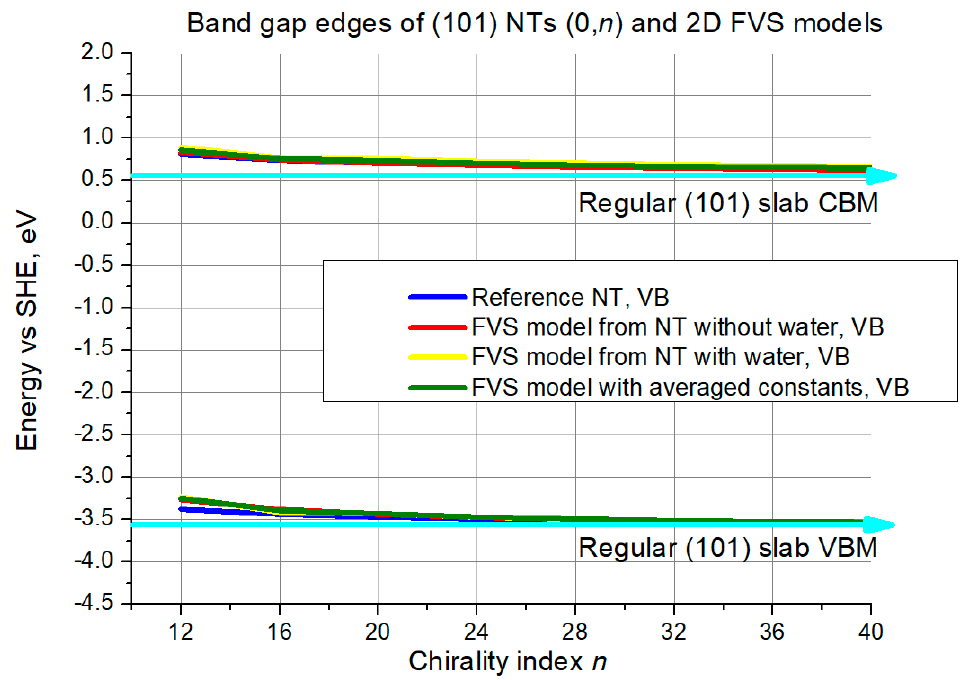
Figure 9. VB top and CB bottom edge positions for (101) NTs (0, n ) and their 2D FVS models. The cyan lines with arrows denote slab limit for VB maximum and CB minimum.